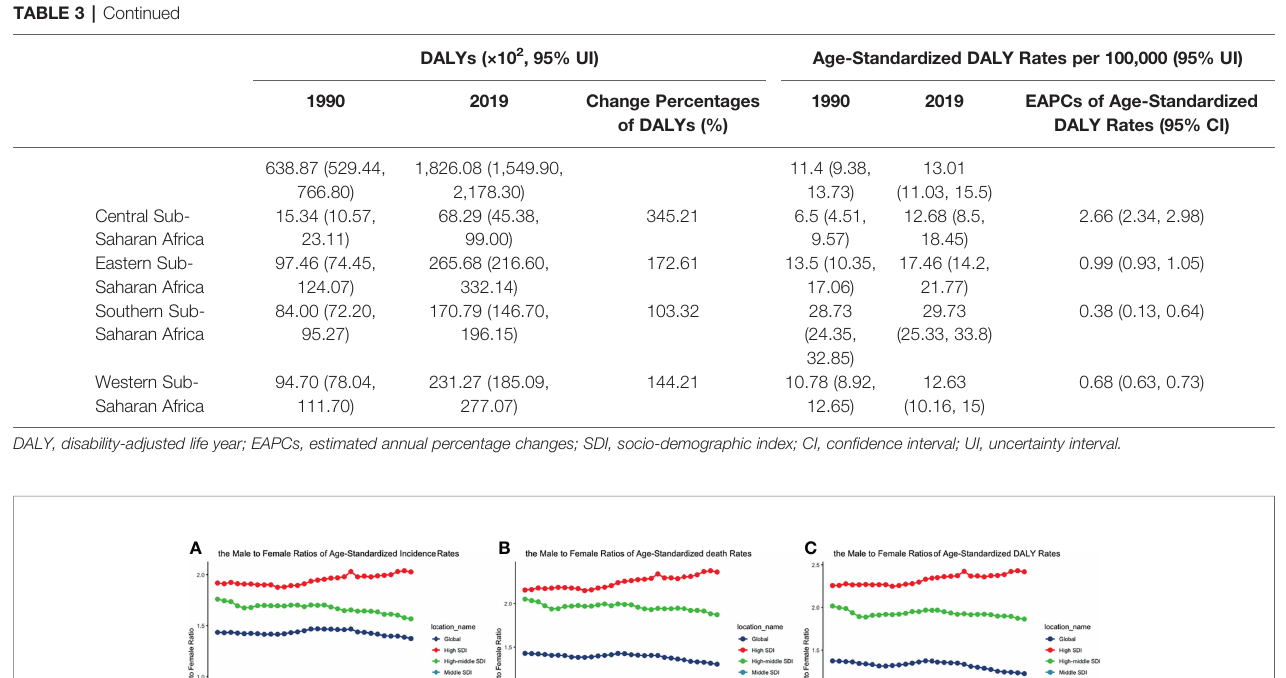
Table S6 , Figure 2G , Figure 3 lower). In terms of geographical regions, Southern Sub-Saharan Africa (29.73 (25.33, 33.8) per were the top two regions with the highest DALY rates in 2019. The EAPCs of age-standardized DALYs rates varied in different geographical regions: from the highest [Central Sub-Saharan